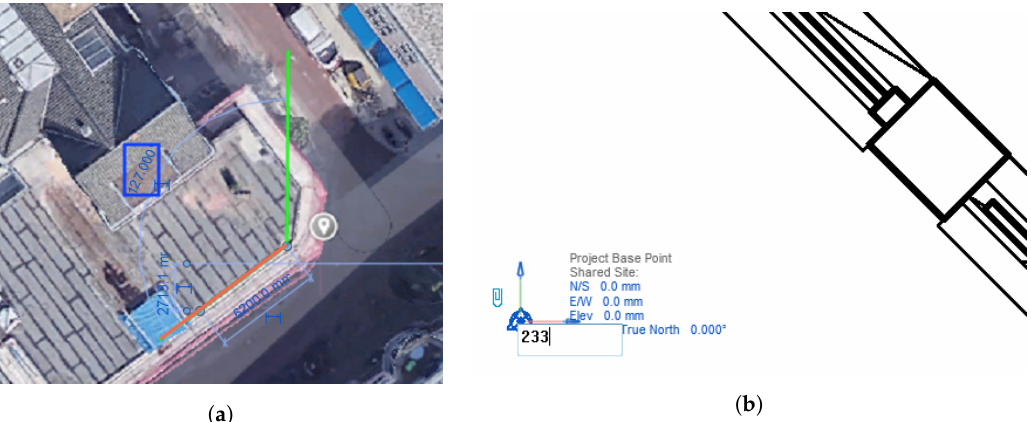
Figure 18. Detection and correction of an IFC file’s TrueNorth . ( a ) Finding of the angle between the true north (green line) and the project north (orange). ( b ) Correction of the Project Base Point’s True North